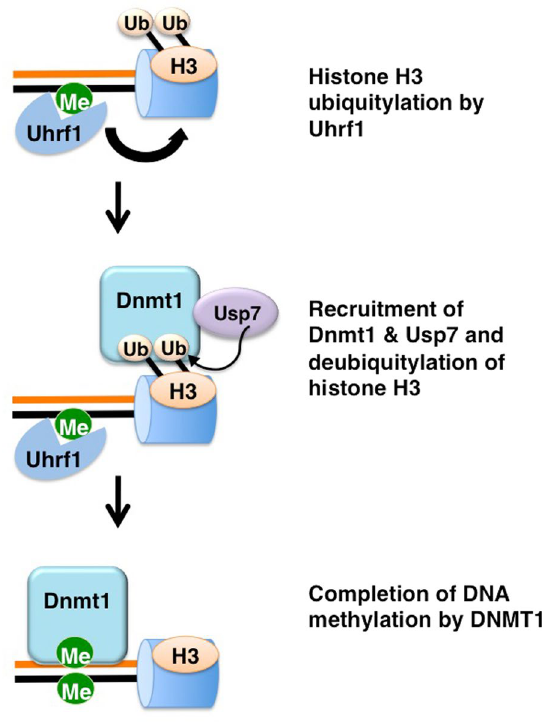
Figure 7. A schematic model showing the role of Usp7 in the maintenance of DNA methylation. During S-phase, Uhrf1 binds to hemi-methylated DNA and ubiquitylates histone H3. Ubiquitylation of histone H3 facilitates the recruitment of Dnmt1/Usp7 complex to DNA methylation sites. Usp7 then deubiquitylates ubiquitylated histone H3, promoting DNA